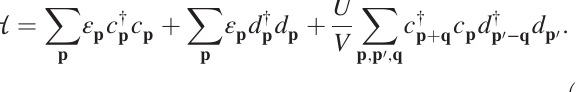
FIG. 2. Raman spectra of an imbalanced Fermi gas in the BEC- BCS crossover. The Raman transition probes the minority atoms, which represent around 4% of the whole cloud. The data are fit with the function given in Eq. (6) (solid lines). The dark shaded area under the graph is the combined contribution from molecules and the incoherent part of the polaron wave function, P ω ; T ; E b Þ , while the light shaded area is the coherent bg ð bg ω ; T ; ϵ 0 ; m (cid:2) Þ . We extract the po- polaron contribution, P p coh ð pol laron energy ϵ 0 from the peak position (dotted vertical lines), pol shifted by the recoil energy due to the finite Raman momentum transfer of ¯ q ≈ 1 . 9 k F . The second and third graphs from the bottom are vertically shifted for clarity by 0.1 and 0.3, respec- tively. In the inset, we depict the data at ð k F a Þ − 1 ¼ 0 . 75 multiplied by ω 3 = 2 to demonstrate the power-law scaling of the high-frequency tail. Each point is an average of three experiments, and the area below each curve is normalized to unity. Since the measurement is done up to some maximal frequency, to properly normalize the data we must account for the missing spectral weight in the unmeasured tail. This is done by adding to the normalization the integral of ω − 3 = 2 up to an energy cutoff of ℏ 2 =mr 2 0 , where r 0 ≈ 181 a 0 is the effective range of the interparticle potential